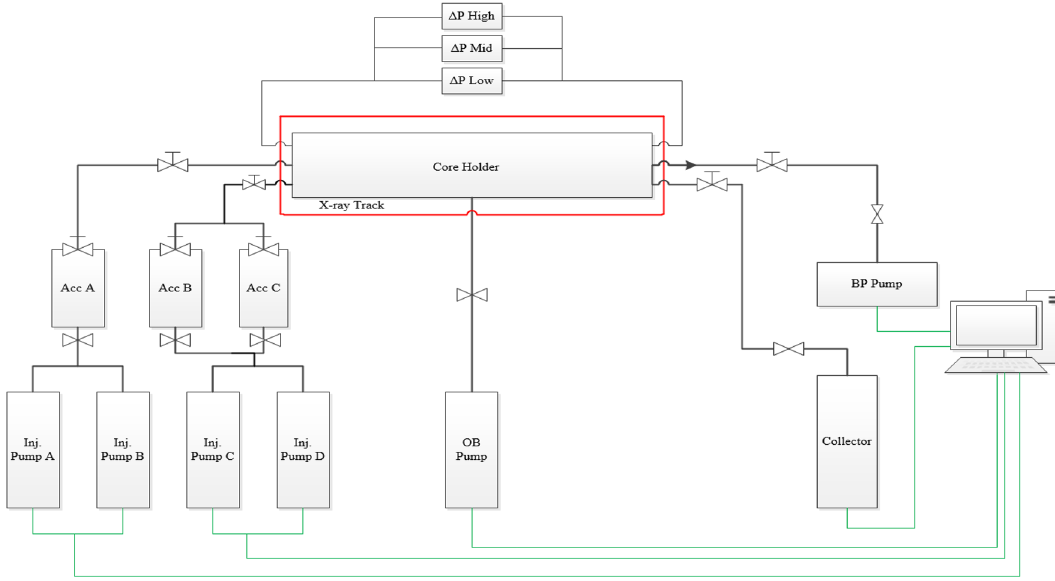
Fig. 1 Schematic of linear X-ray core flood equipment (LXRCF) used for conducting core flood